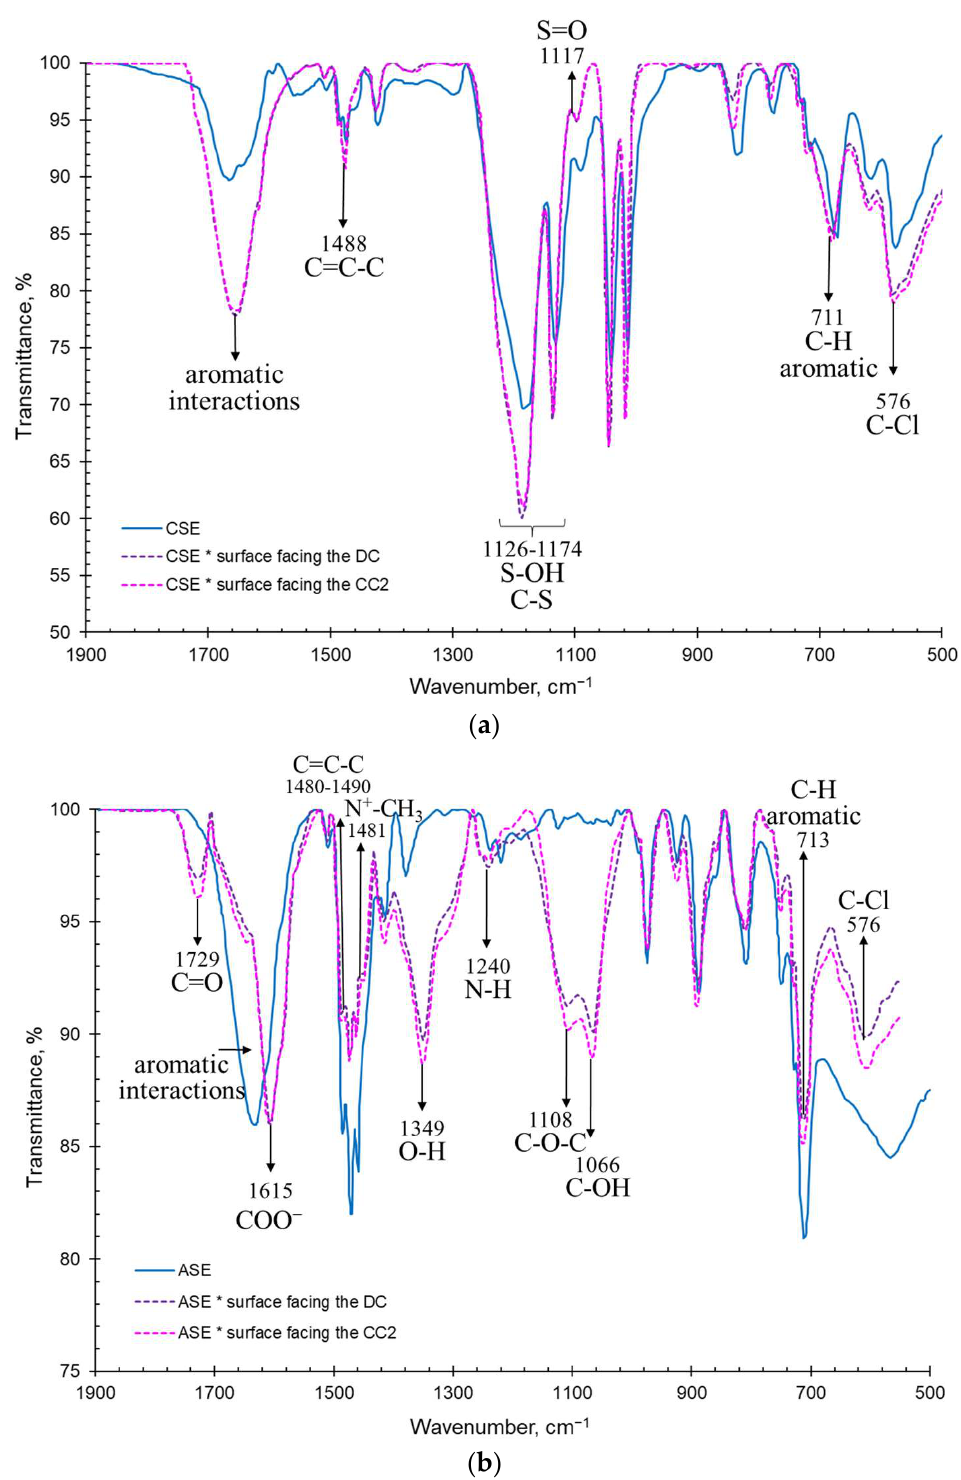
Figure 7. IR spectra of CSE ( a ) and ASE ( b ) membranes before and after ED. The pristine membranes CJMA-3 and CJMC-3 (Figure 6) have a fluoropolymer aliphatic matrix, which is indicated clearly by the peaks inherent to both of these membranes. The strong absorption bands at 1768 cm − 1 and 877 cm − 1 characterize asymmetric and sym- metric vibrations of the CF 2 bond, respectively [74]. The range of 1200–1300 cm − 1 refers to vibrations of the C-F bond [75]. In addition, both membranes have an